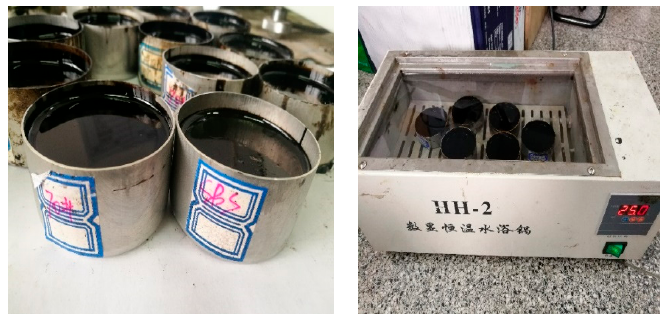
Figure 1. Asphalt samples and the process of the water bath.